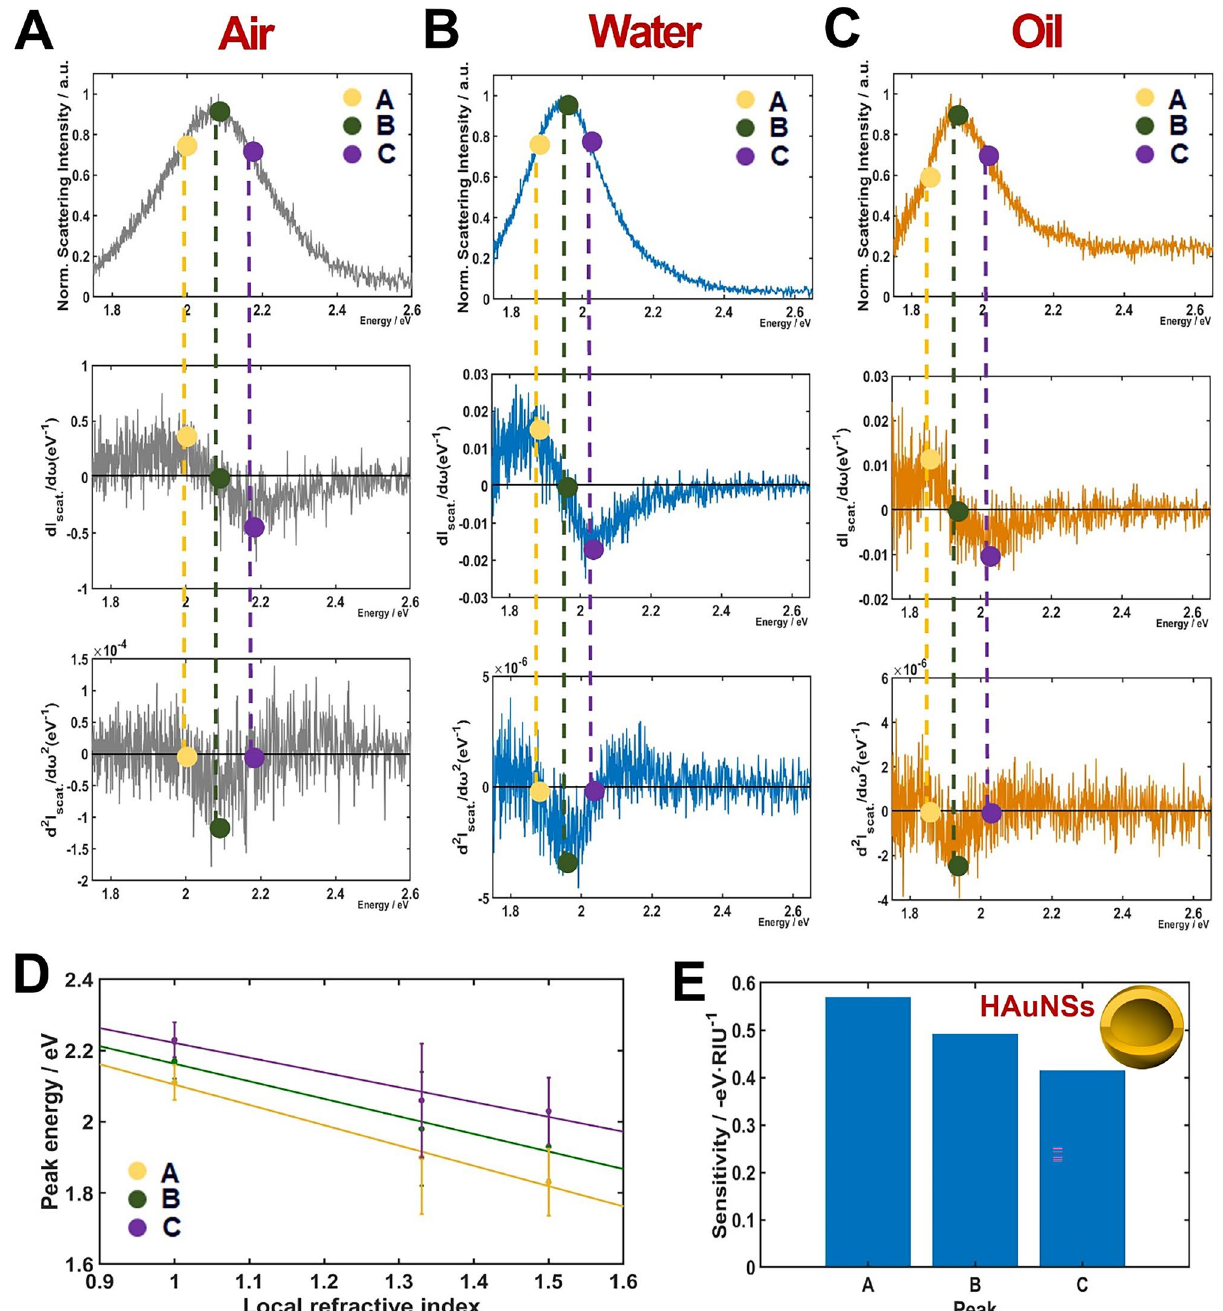
Figure 5. Inflection point method for the single-particle LSPR scattering sensing with HAuNSs in air, water and oil. ( A – C ) LSPR scattering efficiencies (first row) and their first (second row) and second (third row) order derivatives. ( D ) Peak energies plotted against the RI of air, water and oil for points A, B and C, respectively. ( E ) Sensitivity of local RI media on peak shifts A, B and